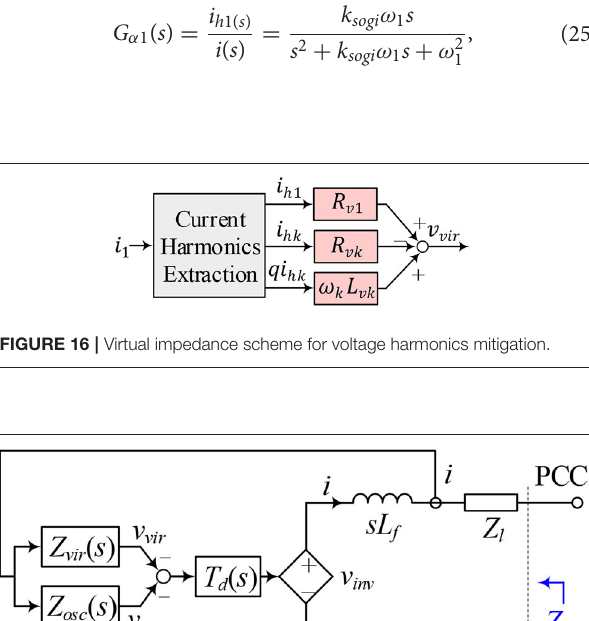
FIGURE 18 | Bode plots of Z tot ( s ) and Z totori ( s ) with V nom